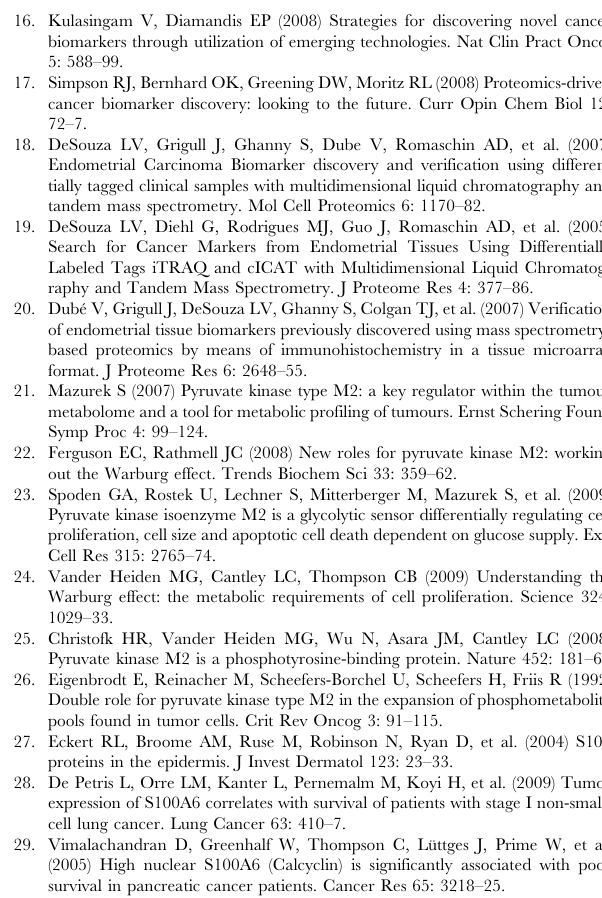
Figure S1 MS/MS spectrum of peptide LQDAEIAR from protein S100-A6. Figure S2 MS/MS spectrum of peptide VCPFAGILEN- GAVR from beta-2 glycoprotein 1. Table S1 Protein average iTRAQ ratios and t-test results. Table S2 Individual iTRAQ ratios of biomarker candi- dates. Average ratios per sample: C= endometrial carcinoma, N= normal proliferative endometrium. The proteins from the tables S2a and S2b here were reported in Tables 2 and 3 in the article, respectively. Table S3 Confidence of identified peptides. A - Identified peptides whose Proteinpilot confidence was greater than 95%.